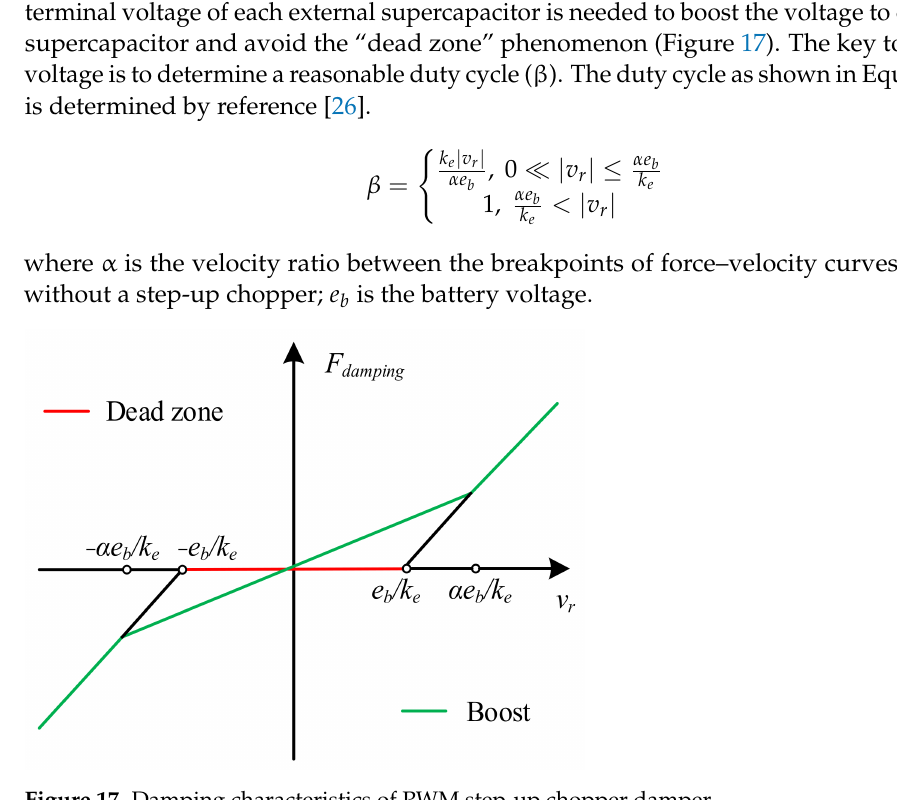
Figure 17. Damping characteristics of PWM step-up chopper